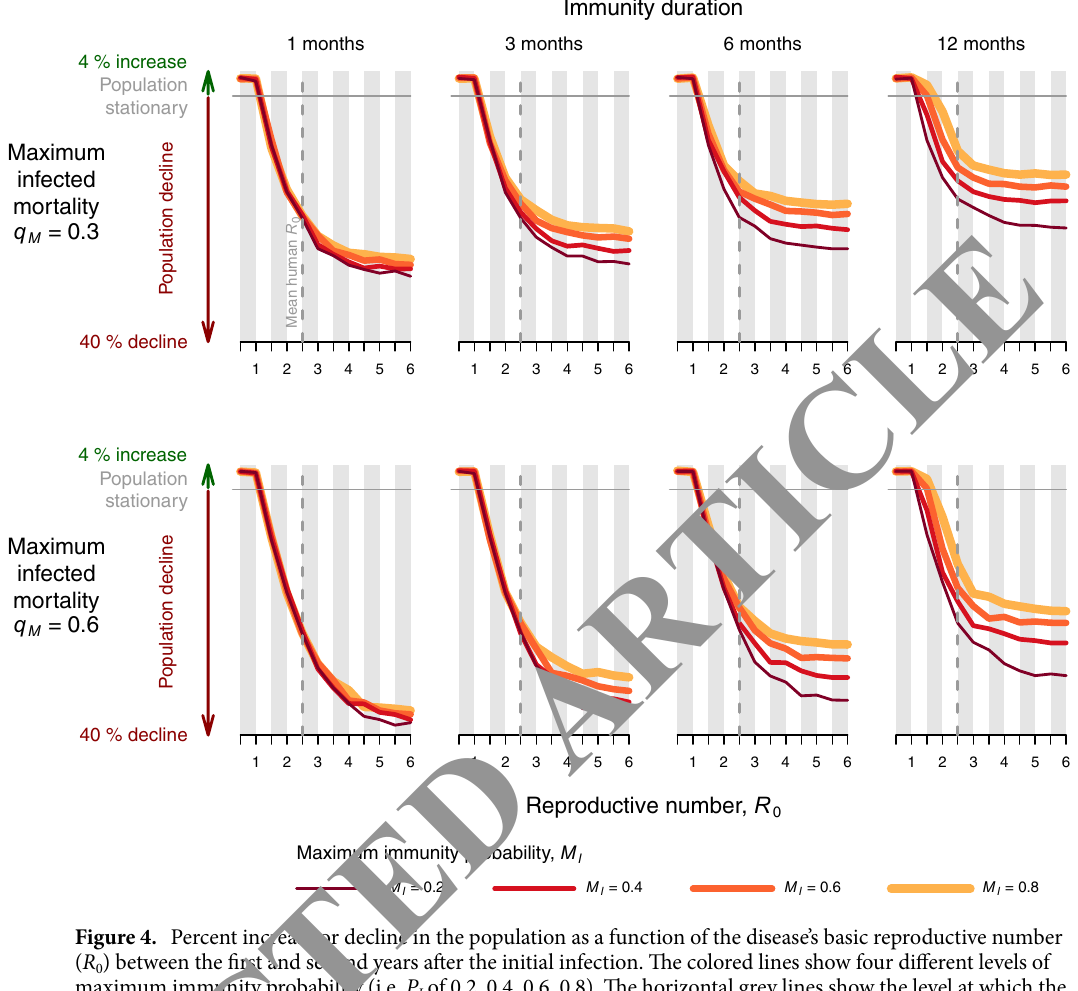
Figure 4. Percent increase or decline in the population as a function of the disease’s basic reproductive number ( R 0 ) between the first and second years after the initial infection. The colored lines show four different levels of maximum immunity probability (i.e. P I of 0.2, 0.4, 0.6, 0.8). The horizontal grey lines show the level at which the population is stationary, and the vertical dashed lines show the mean human R 0